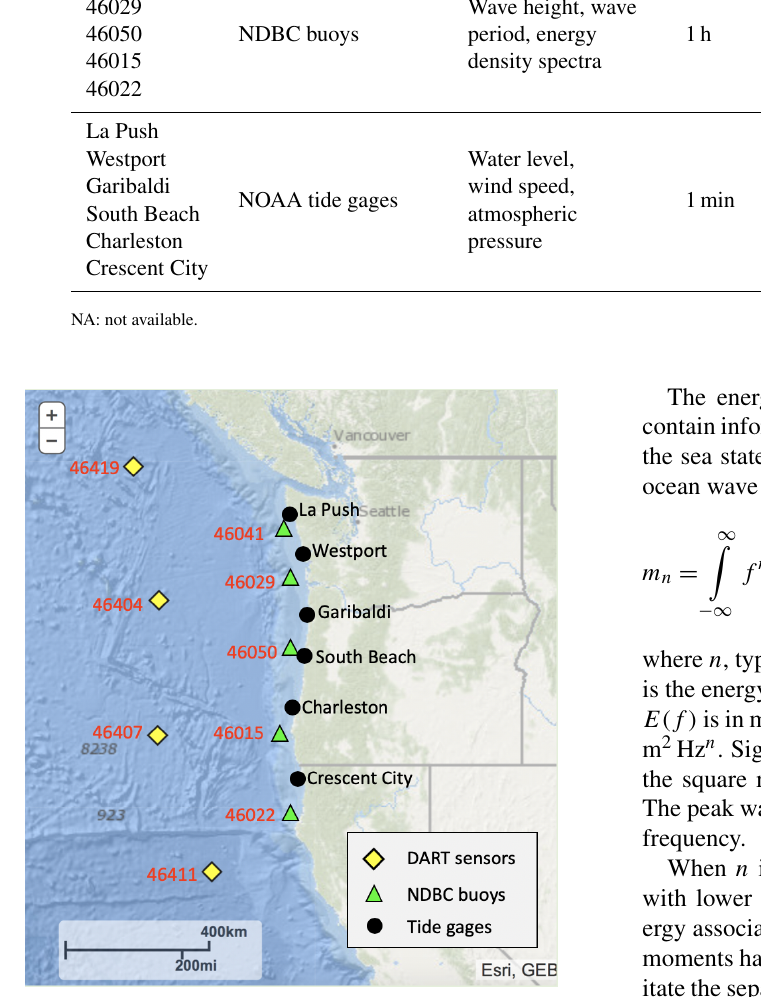
Figure 3. Locations of observation sites (map from NOAA, 2020a).